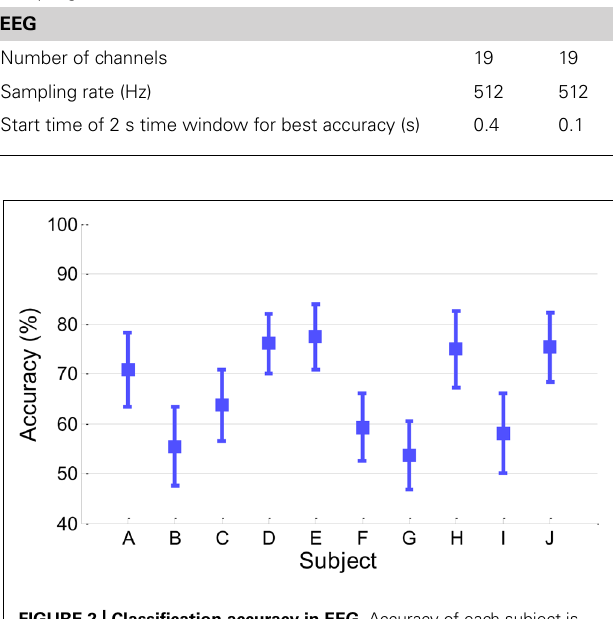
FIGURE 2 | Classification accuracy in EEG. Accuracy of each subject is presented with its standard deviation.